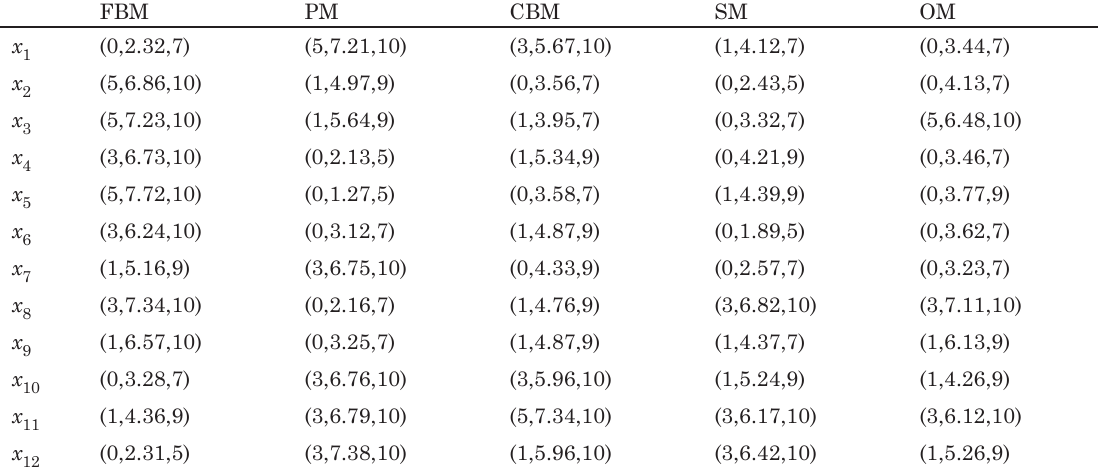
table 5. Aggregated fuzzy rating of maintenance